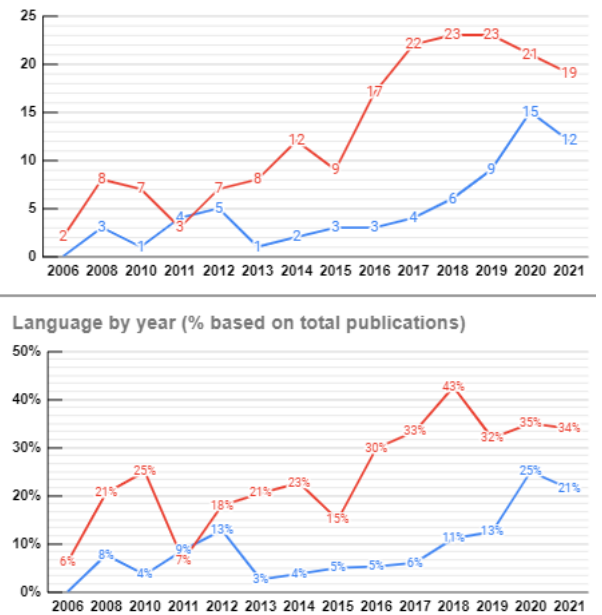
Figure 10. Language of papers containing ethical